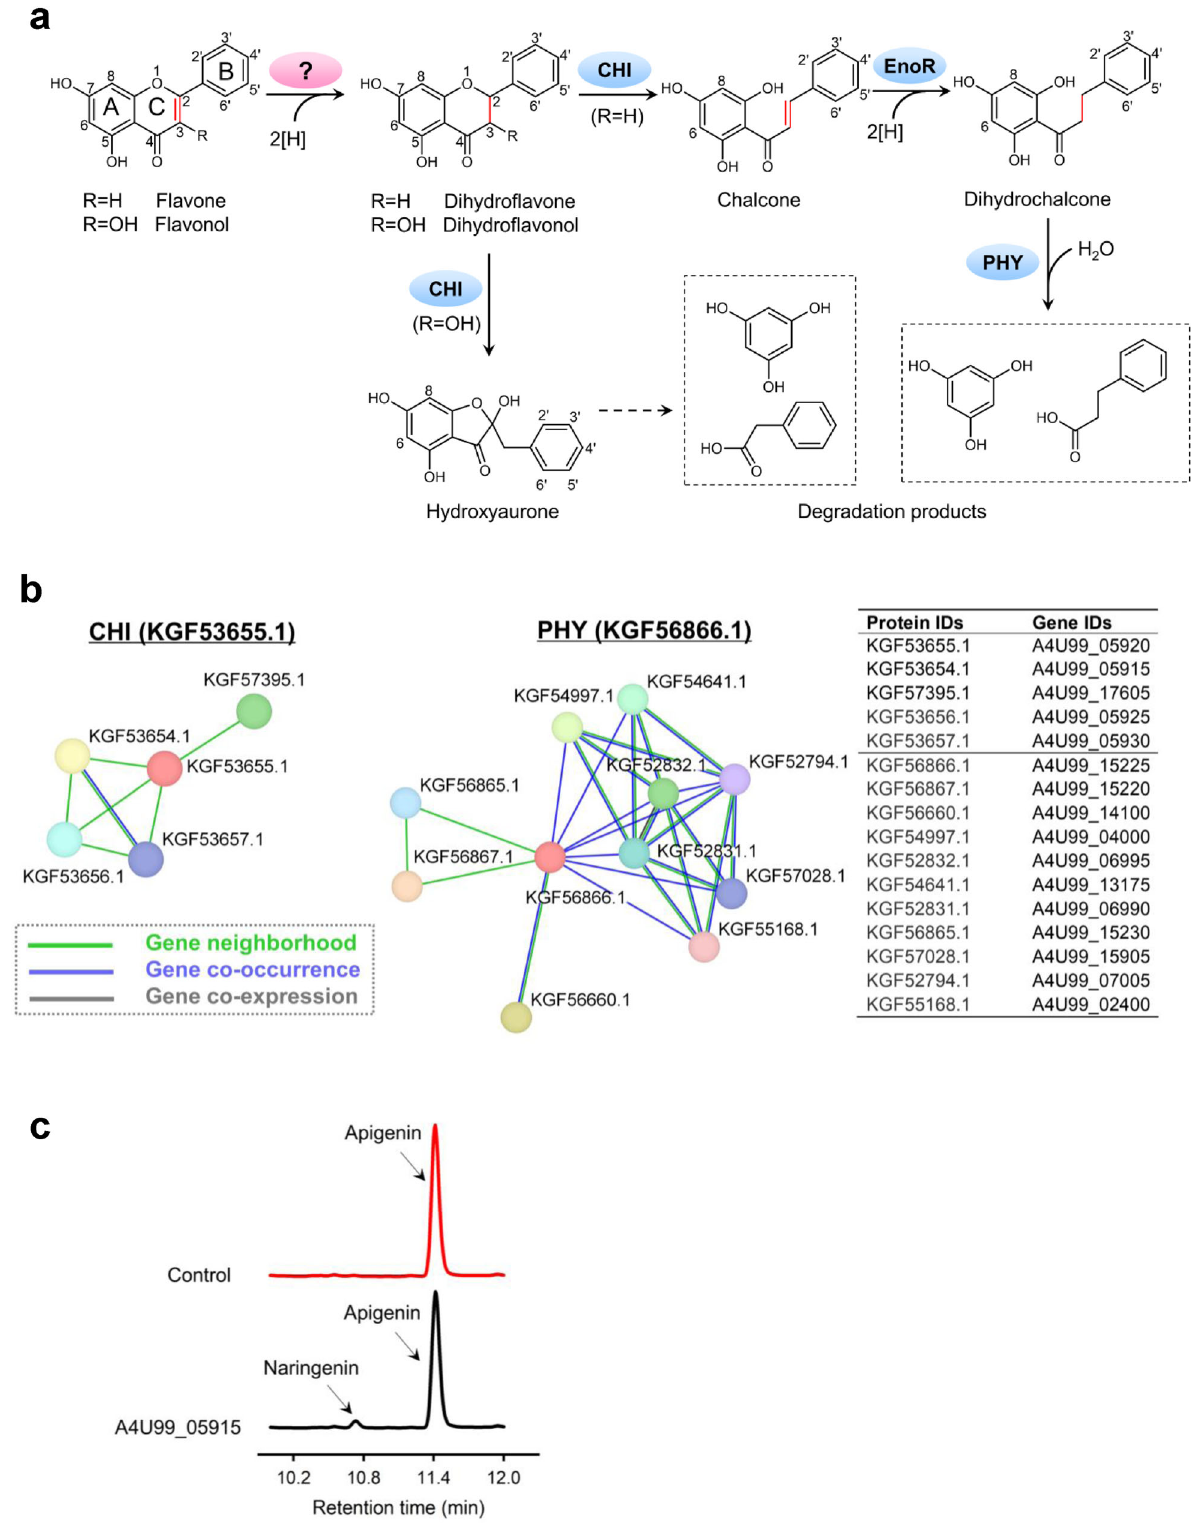
Fig. 1 Discovery of the fl avone reductase (FLR) in F. plautii ATCC 49531. a Proposed microbial metabolic pathway for fl avones and fl avonols. Enzymes that were identi fi ed are indicated with blue ellipses. The question mark in the pink ellipse indicates that the enzyme responsible for this step is missed. CHI, chalcone isomerase; EnoR, enoate reductase; PHY, phloretin hydrolase. b Fourteen potential FLR enzymes generated by the comparative genomic analysis of F. plautii ATCC 49531. c HPLC detection of the conversion of apigenin to naringenin by the E. coli strain (BL21) expressing the A4U99_05915 gene (coding for the KGF53654.1 protein from F. plautii ATCC